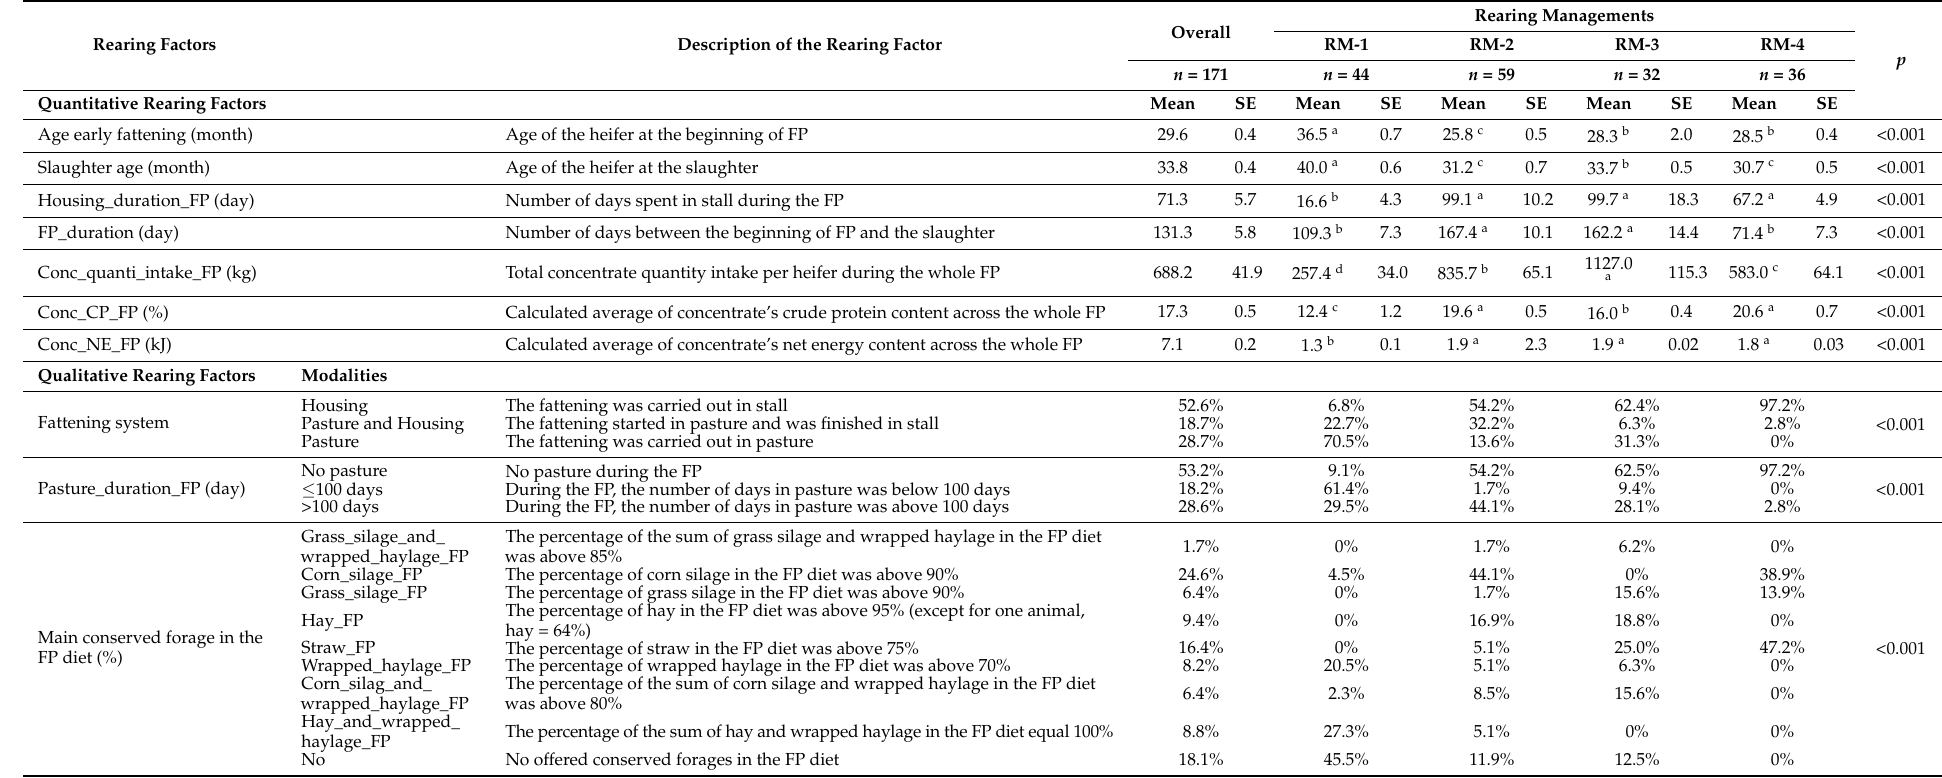
Table 3. Rearing factors characterizing the fattening period (FP) of the rearing managements (RM) applied during the heifers’ whole